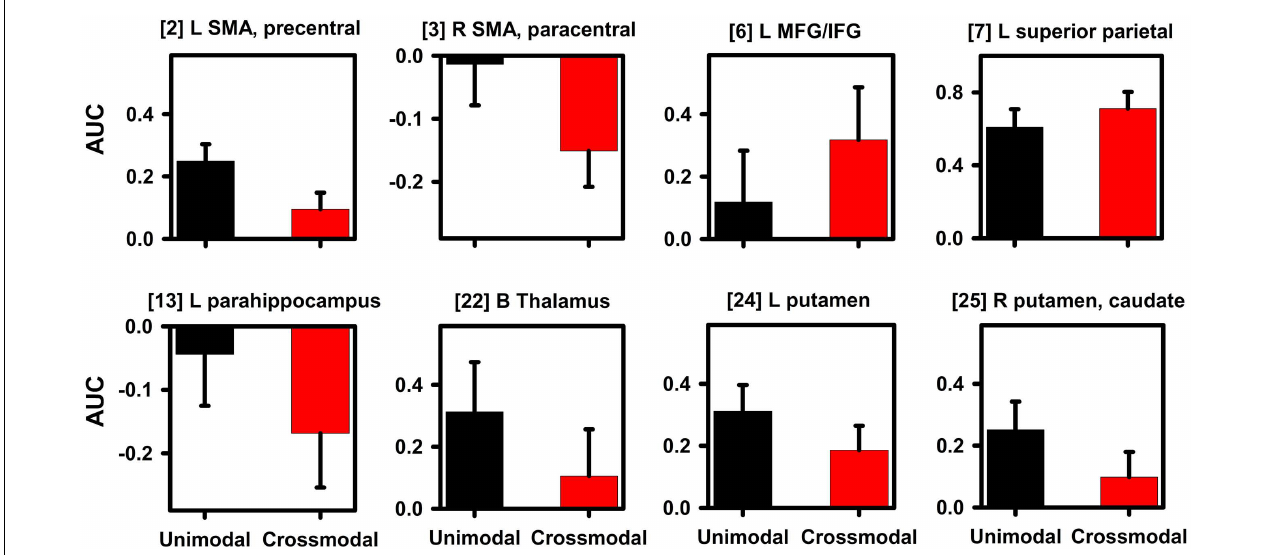
for each condition. Bracketed numbers reference regions detailed in Table 1 . L, left hemisphere; R, right hemisphere; B, bilateral hemispheres; SMA,